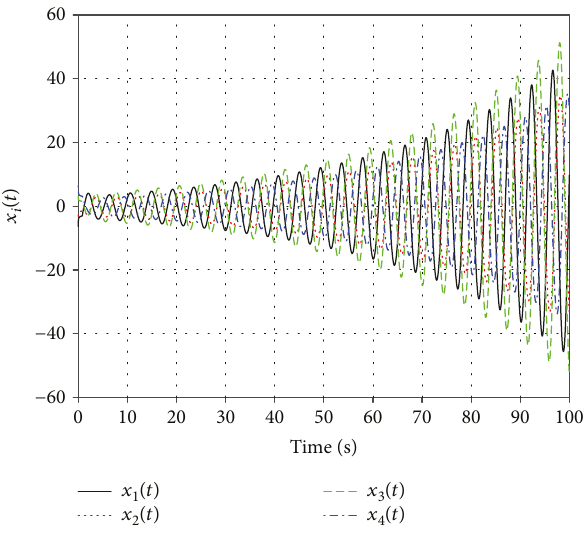
t applying the protocol in (6) i 1